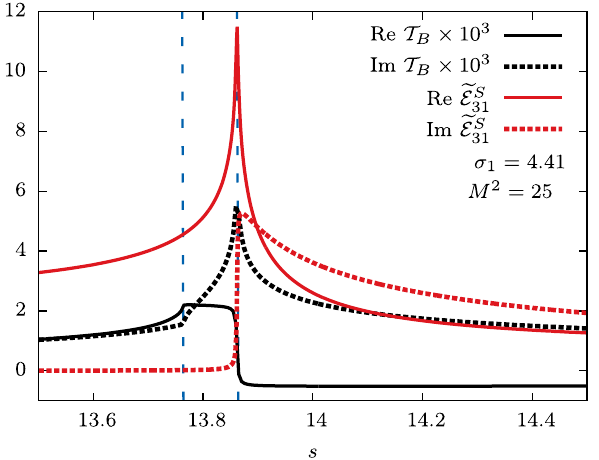
Fig. 16 The B -matrix triangle Eq. (54) in with the triangle singular- ity. Shown in black are the real (solid) and imaginary (dashed) parts evaluated at σ 1 = 4 . 41 and M 2 = 4 . 41. Shown in red are the real (solid) and imaginary (dashed) parts of the OPE piece of the trian- = M 2 . The blue dashed lines indicate the gle, Eq. (44), where σ (cid:6)(cid:6) 3 threshold ( M + m 3 ) 2 = 13 . 7641 and the lower RPE branch point at = s = 13 . 8619. The normal threshold accounts for the first peak s ( − ) tr 31 in the triangle diagram, while the second peak is caused by the triangle